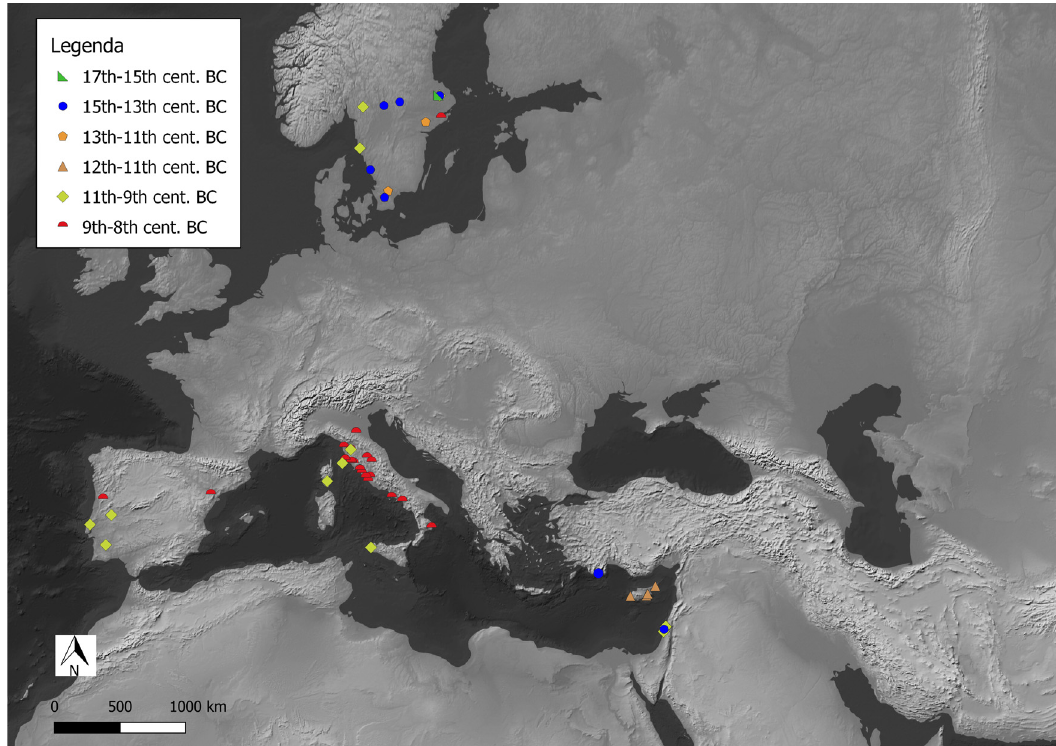
Figure 10: Total distribution of Nuragic metalwork ( ingots and artefacts ) in the Mediterranean Sea and beyond. The map includes Nuragic artefacts found in the Iberian Peninsula and the Italian Peninsula ( red ) dated to the EIA ( albeit no LIA available ) . ( Data source: Bernabale et al., 2019; Eshel et al., 2019; Ling et al., 2014; Milletti & Santocchini Gerg, 2015; Stos - Gale & Gale, 2010; Wachsmann, 2020; elab. Map Valentina Matta © )